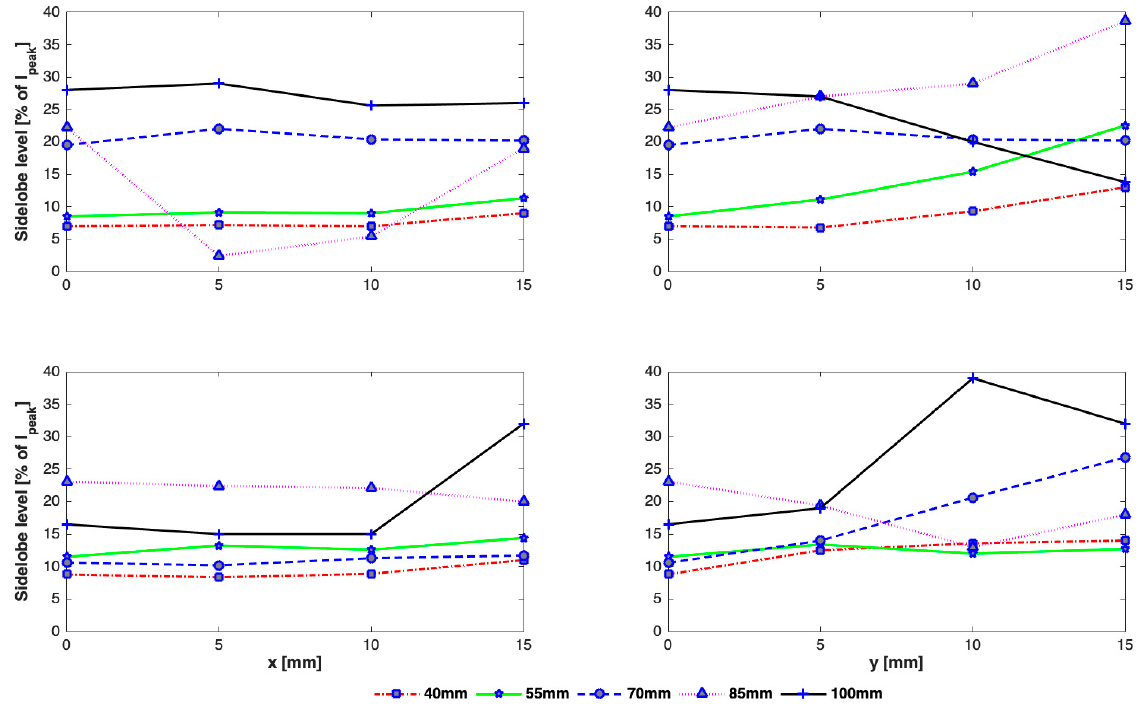
Figure 10. Change in the magnitude of secondary foci with transverse steering for rib cage positioned at 40 mm, 55 mm, 70 mm, 85 mm, 100 mm and when the array axis crosses center of the rib ( top row ), intercostal space ( bottom row ), steered in x-direction ( left column ), y-direction ( right column ).